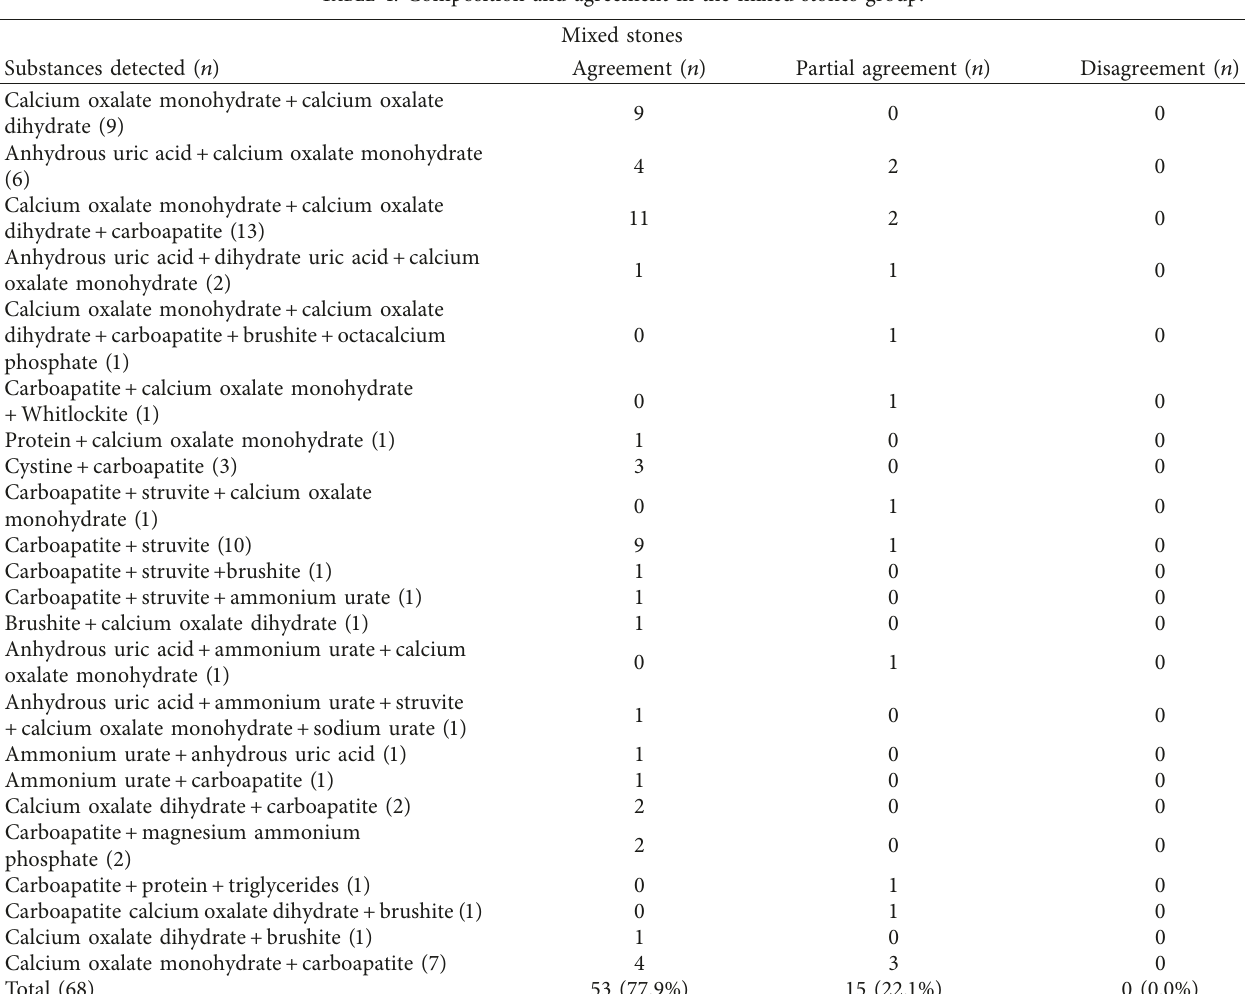
Table 4: Composition and agreement in the mixed stones